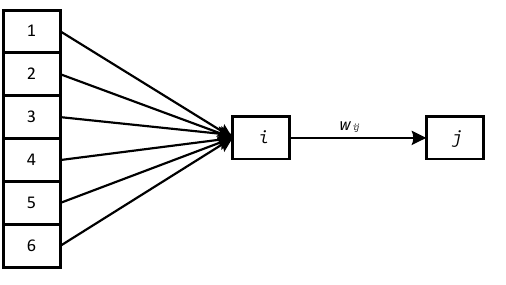
Figure 4. Sample data activation.